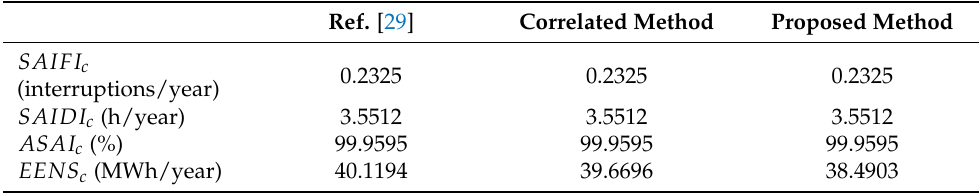
Table 3. Reliability indices for the distribution network at bus 5 of the